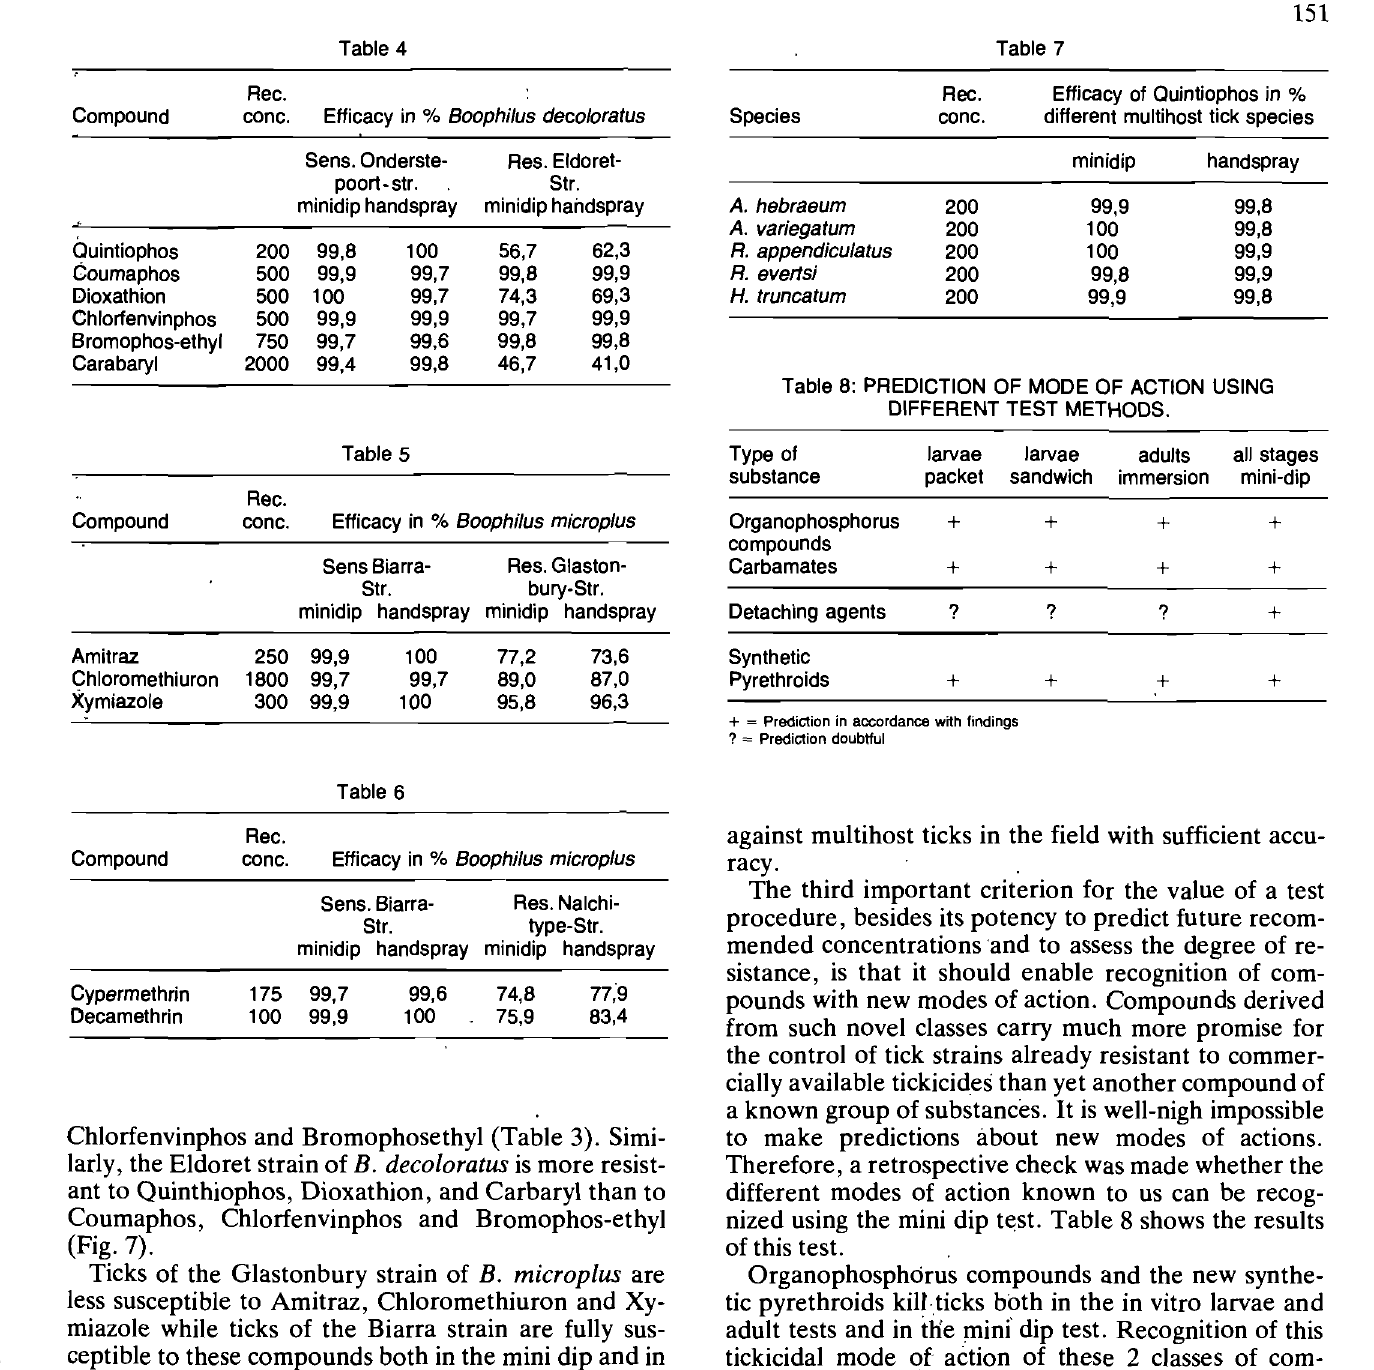
Efficacy in % Boophilus decoloratus Sens. Onderste-